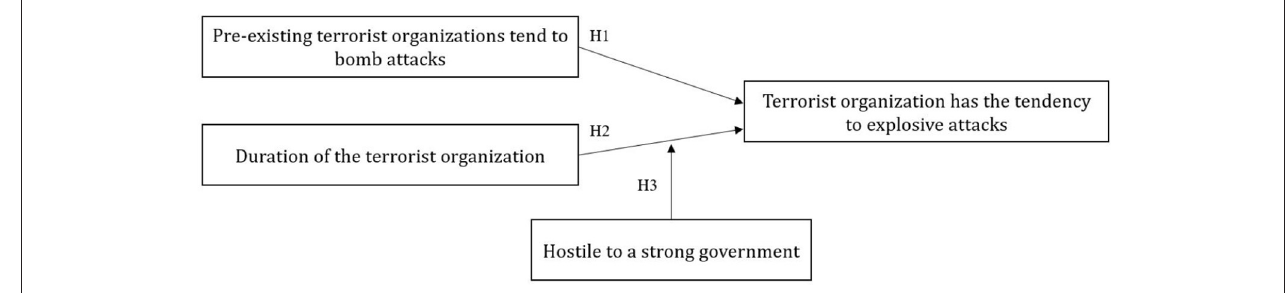
FIGURE 3 | A hypothetical model of the terrorist organizations to conduct explosive